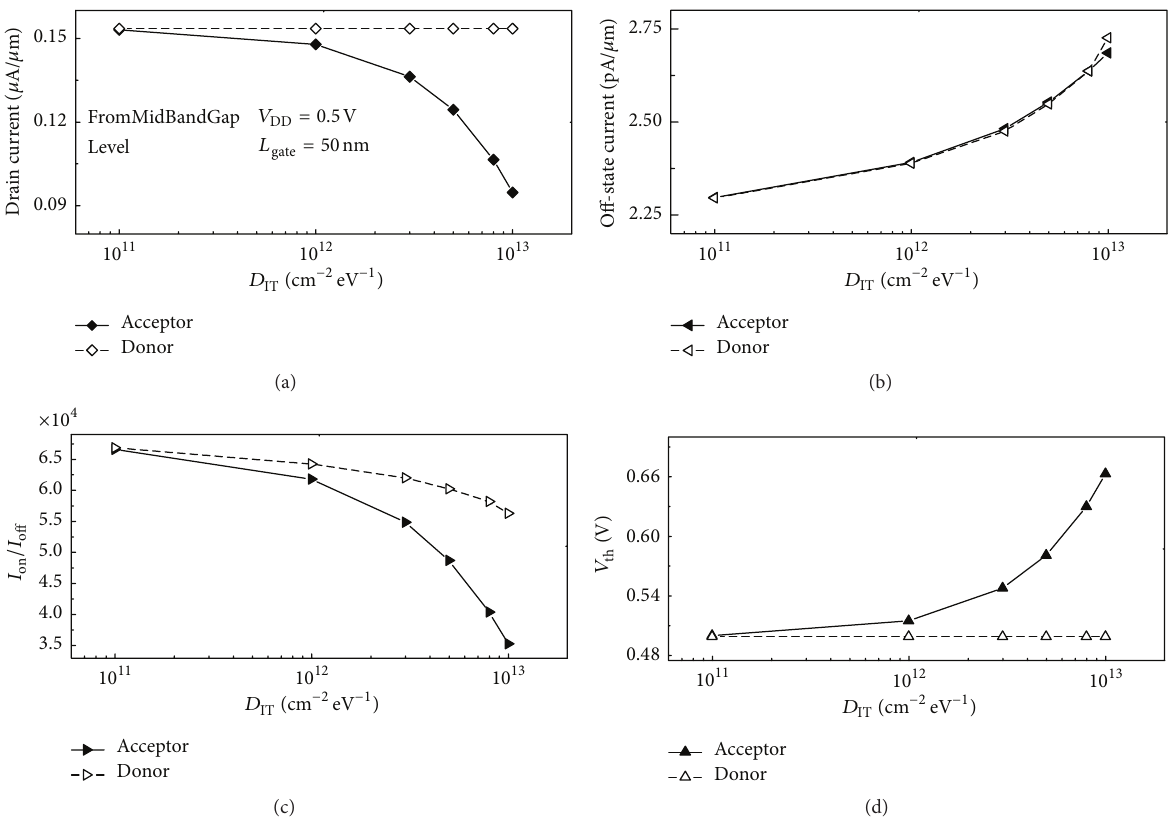
= 𝑉 = 0.5 V, (b) off-state 𝐼 at 𝑉 on GS DS